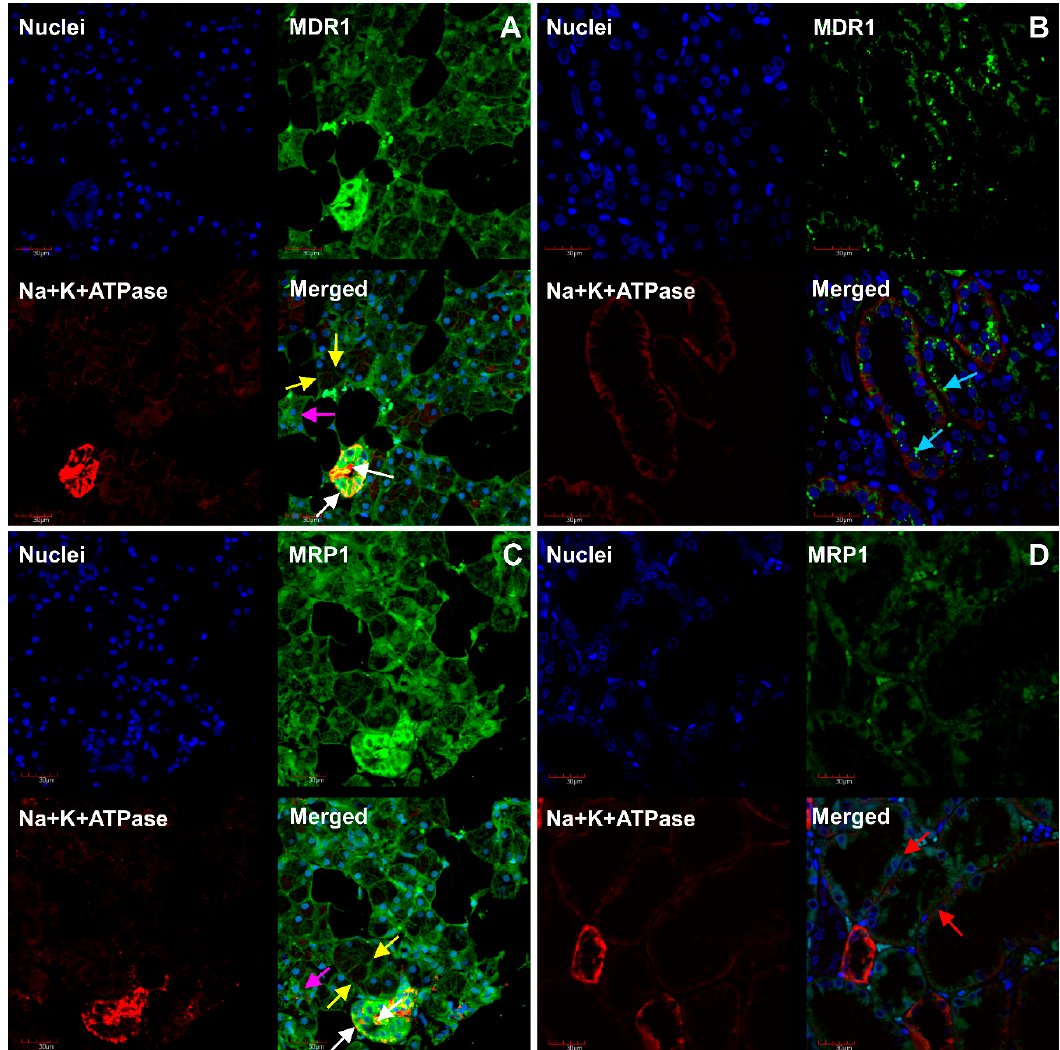
Figure 4. Immunofluorescence staining of MDR1 / P-gp and MRP1 in salivary glands and kidney cortex. ( A ) MDR1 (green panel) expression at the basolateral and apical membrane of serous and mucous acinar cells and in duct cells. ( B ) MDR1 (green panel) expression at apical membrane of kidney proximal tubule. ( C ) MRP1 (green panel) detection at the basolateral and apical membrane of serous and mucous acinar cells and in duct cells. ( D ) MRP1 (green panel) detection at basolateral membrane of kidney distal tubule. Na + / K + -ATPase (red panel A – D ) was used as the basolateral membrane marker. Nuclei are stained blue ( A – D ). Yellow arrow—apical and basolateral membrane of mucous acinar cells; white arrow—apical and basolateral membrane of duct cells; pink arrow—serous acinar cells; blue and red arrow—apical membrane of proximal tubule cells and basolateral membrane of distal tubule cells, respectively.